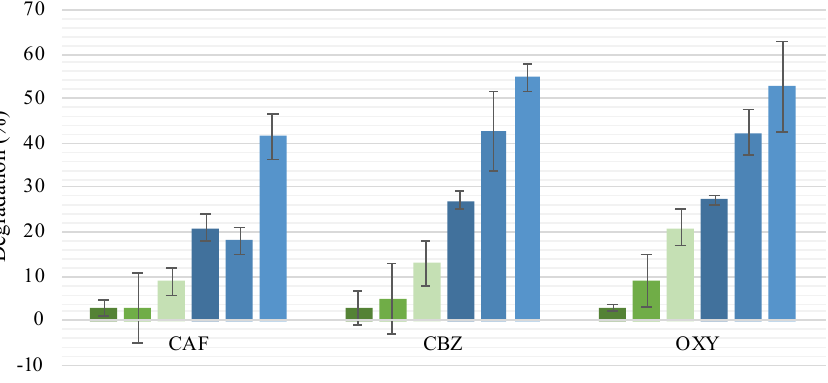
Figure 4. Caffeine (CAF), carbamazepine (CBZ) and oxybenzone (OXY) degradation in Set 1 experi- ments for controls (no current applied) and EC treatment after 2, 4 and 6 h. Standard deviation range represented by the black line.